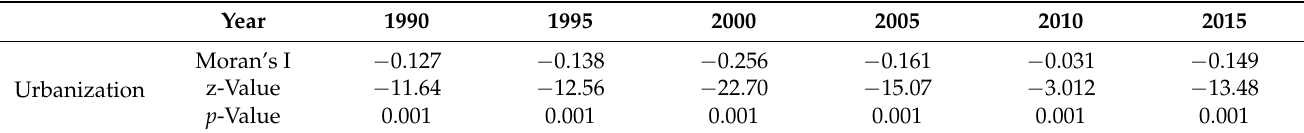
Table 3. The result of Moran’s I.